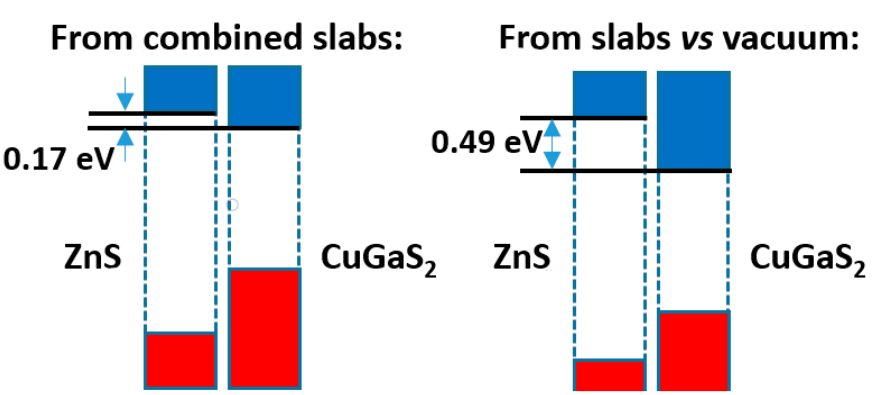
Figure 7. Band offsets for the ZnS|CuGaS 2 interface.